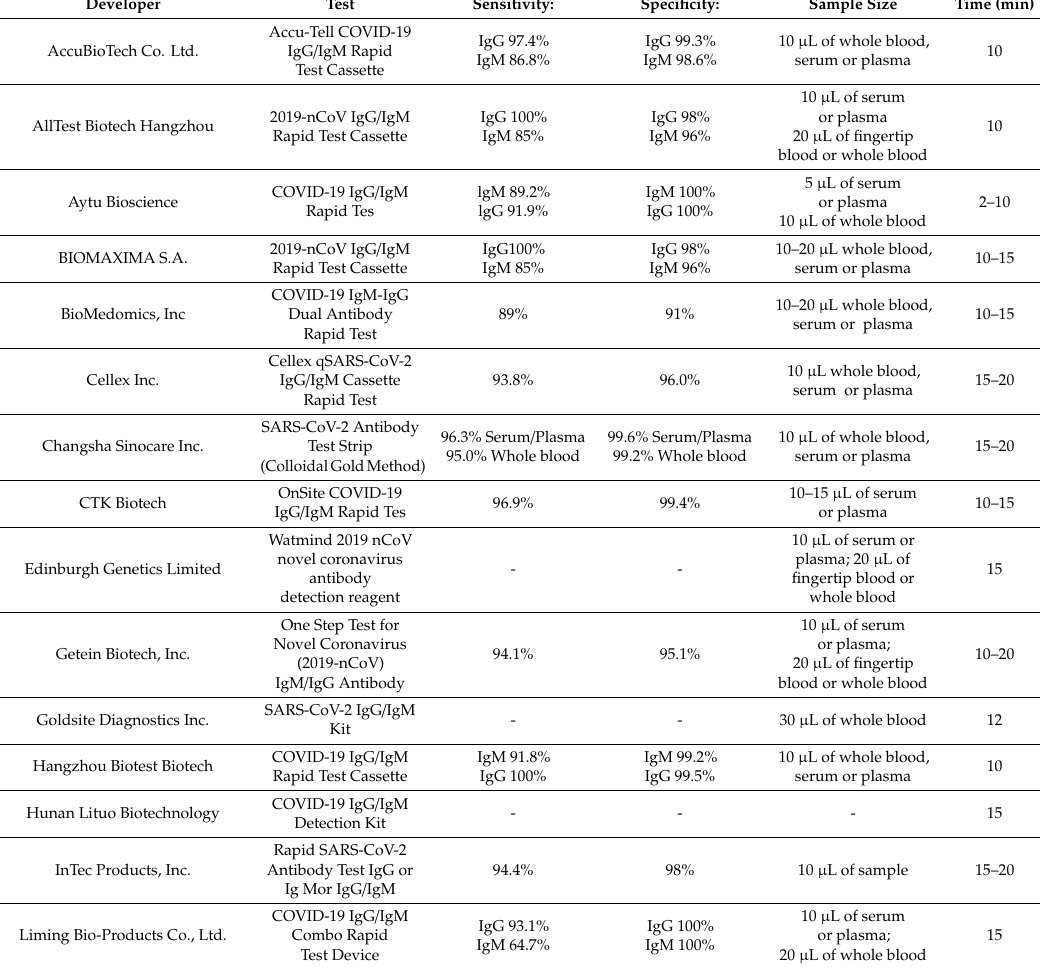
Table 7. Comparison of selected immunochromatographic tests for SARS-CoV-2 based on sensitivity, specificity, sample type and test performance time (updated 13 June 2020, online sources according to manufacturers’ specification).